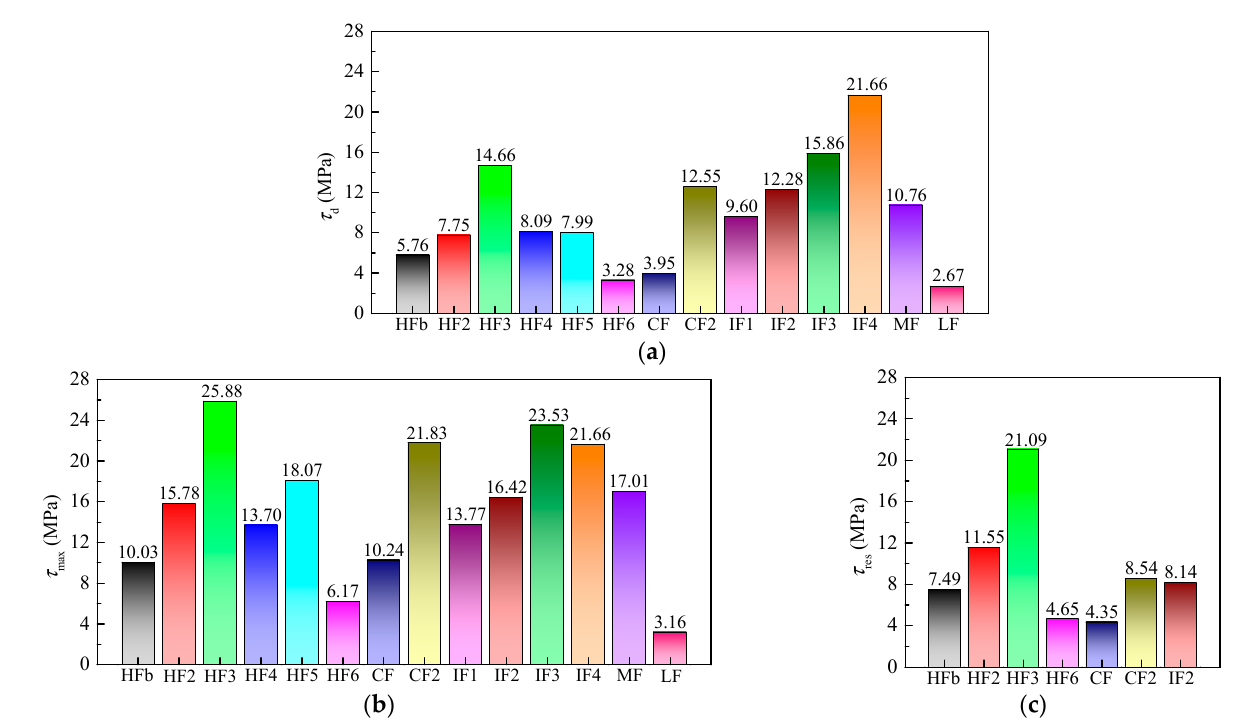
Figure 11. The bond strengths of characteristic points of different deformed steel fibers: ( a ) τ d ; ( b ) τ max ; ( c ) τ res . The crimped steel fiber CF2 has the maximum τ d , τ max , and τ res . CF has the τ d , τ max , and τ res about 31%, 47%, and 51% of CF2, successively. The indentation steel fiber IF3 has the maximum τ max . Next is IF4 and IF2. IF1 has the smallest τ d and τ max of about 61% and